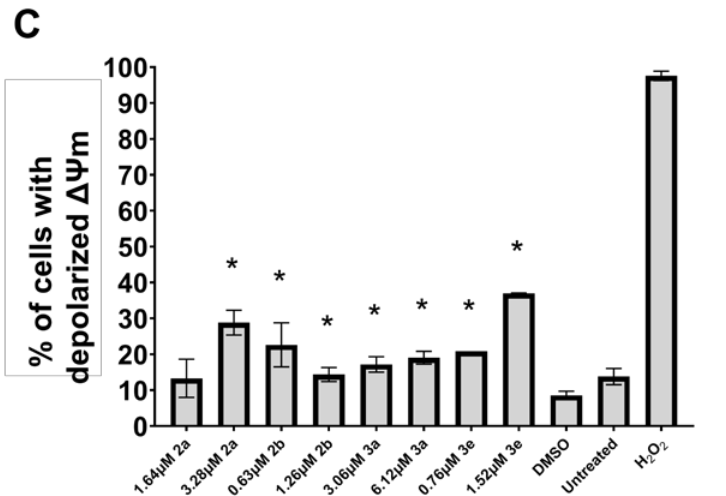
Figure 6. Induction of ROS generation ( A ), apoptosis ( B ), and the depolarization of mitochondrial membrane potential ( C ) by 2a , b and 3a , e in CEM cells. * p < 0.01 compared to DMSO for ( A ), * p < 0.05 compared to DMSO for ( B , C ).